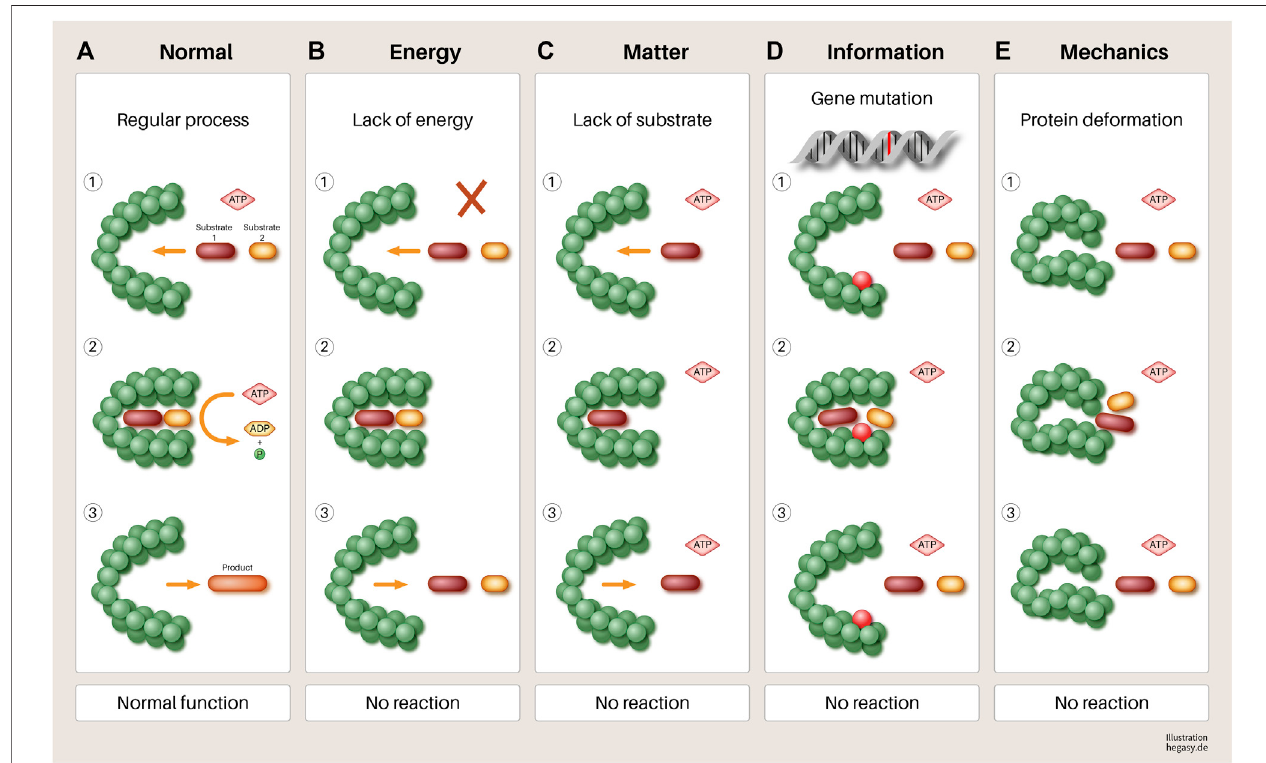
FIGURE5| Usingtheexampleofahypotheticalprotein,itisillustratedinasimplewaythatvariousin fl uences (B – E) canhaveanimpactonitsfunction. (A) Anormal gene istranscribed and translated. When suf fi cient substrates and biological energy are present, itperforms its function, which leads to the required product. (B) lack of biological energy, (C) effect ofmechanical forces (pressureand tensile forces), (D) mutation of agene, and (E) . lack ofsubstrates involved in the process lead toa failure to synthesize the required product and to the accumulation of reactants. If this disturbed mechanism persists, this leads to increasing disorganization of this reaction pathway, in the course of which, further processes can be disturbed. At the end of such a process, dedifferentiated and malignant cells could emerge. Other parameters not shown here that have negative in fl uences are, for example, a non-physiological pH value, high temperatures, altered protein solubility due to low ATP concentration,overcrowdedmilieu,non-physiologicalelectrolyteconcentration,orothermoleculesoftheenvironment.Inaddition,substancesthatarenotendogenous to the body (e.g., toxins) can directly in fl uence the function of enzymes that lead to irreversible changes in the metabolism of the cell without mutations.